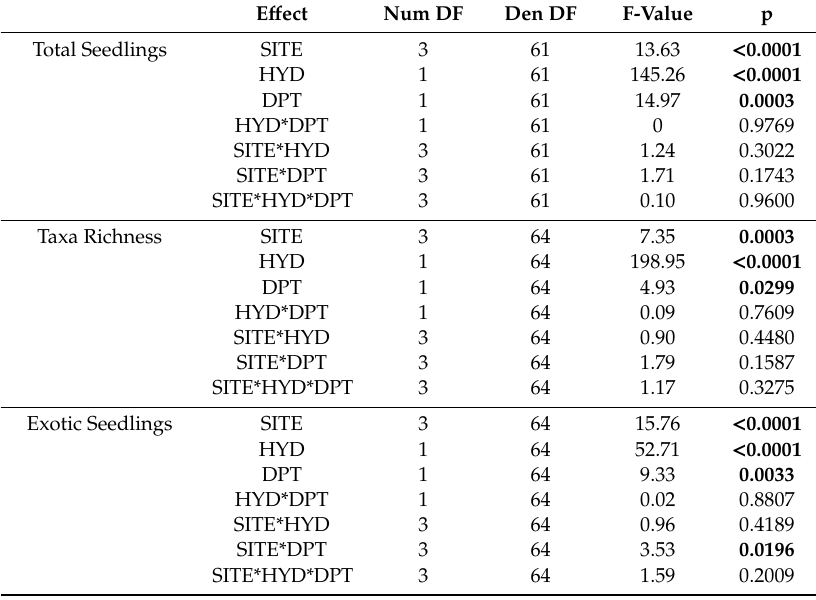
Table 1. Results of three-way ANOVA tests for the e ff ect of wetland location (SITE), hydrology (HYD), soil profile depth (DPT) and their interactions on total number of seedlings, taxa richness of emergent seedlings, and number of exotic